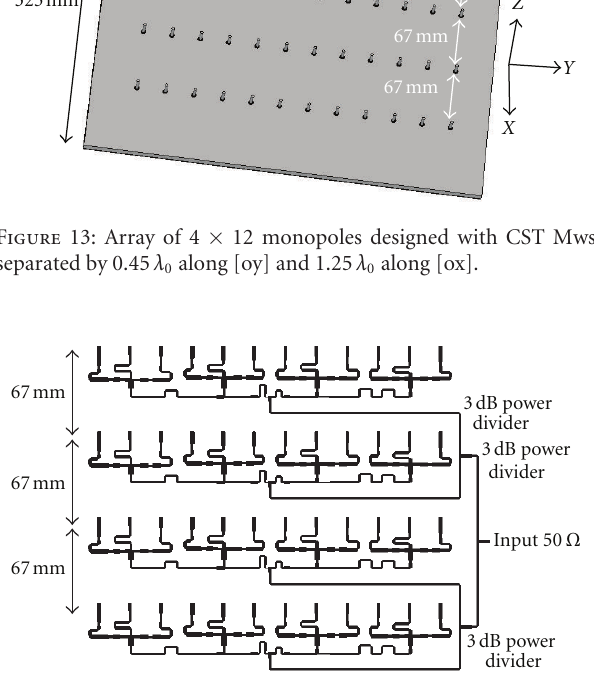
Figure 14: The feed network is designed to the four-subarray